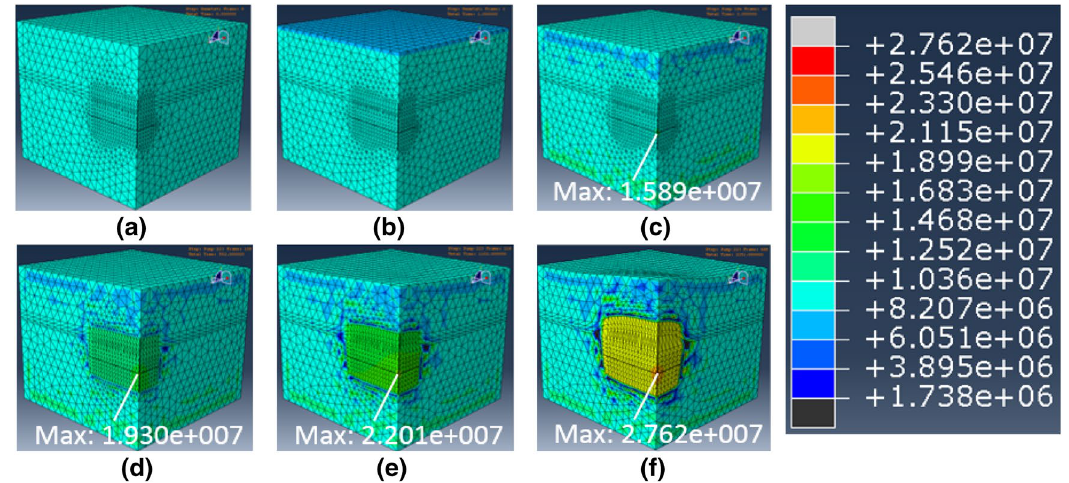
Fig. 3 Case 1 ( k = 23.4 mD): a pore pressure (Pa) following initial condition application, b pore pressure (Pa) following reservoir stresses and boundary conditions application on the domain, c t = 1 s, d t = 551 s, e t = 1101 s and f end of injection at t = 2250 s